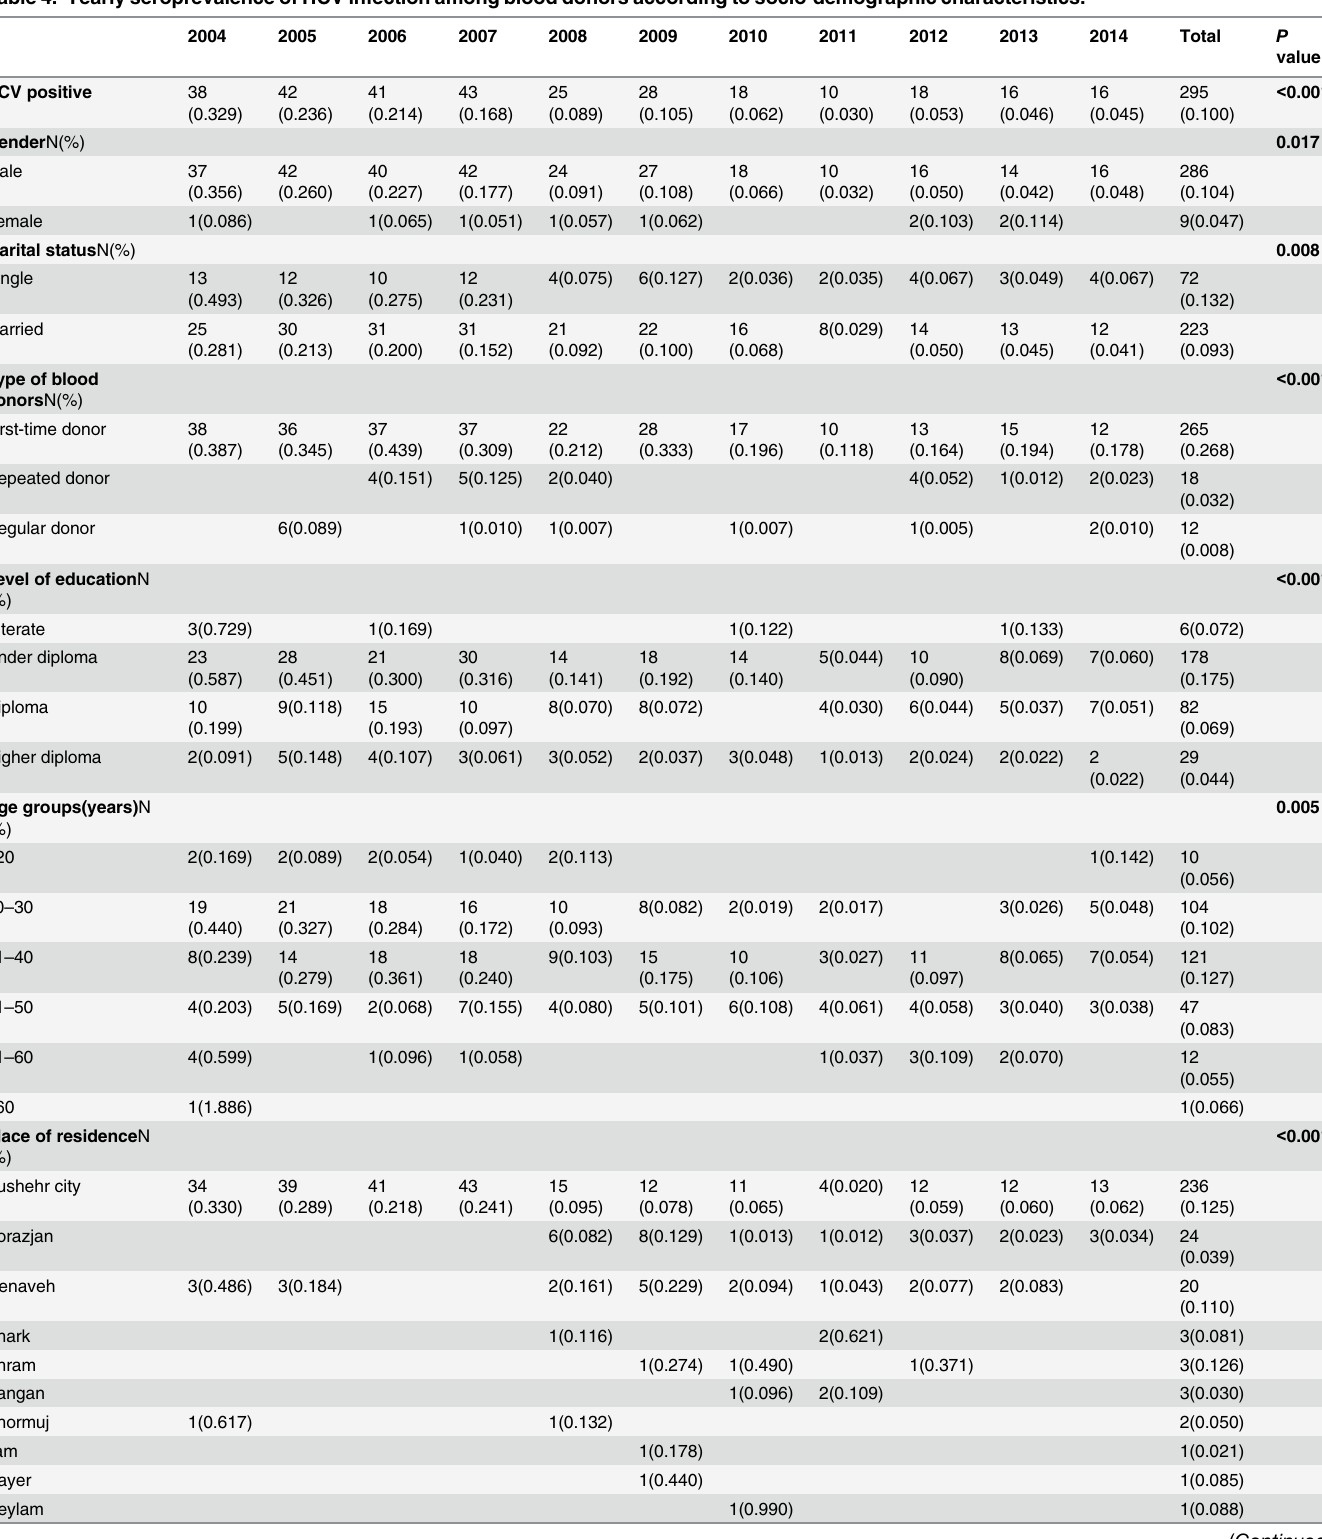
Table 4. Yearly seroprevalence of HCV infection among blood donors according to socio-demographic